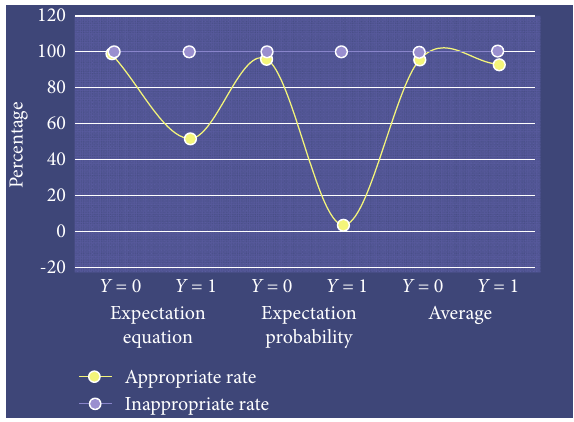
Figure 5: Forecast-expectation analysis of early warning indicators of dynamic model.